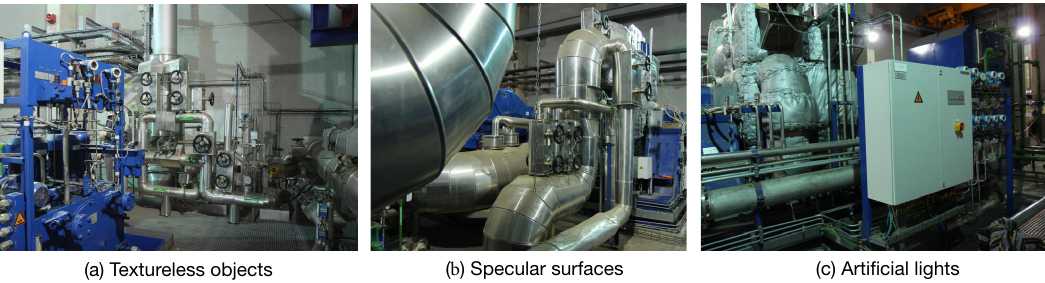
Figure 2. Sample images in industrial